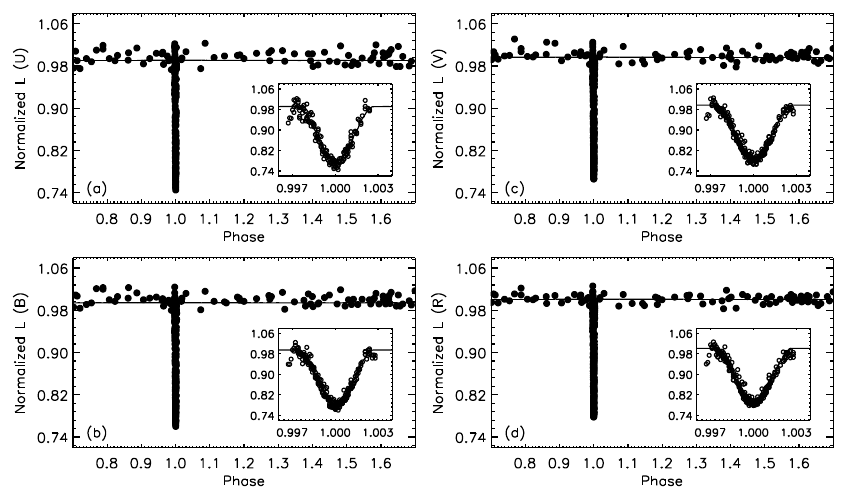
Fig. 2. The UBVR light curves with their theoretical fits. The inserts show the zoomed light curves at the phases of the primary minimum. In the light curve analysis, the radii are quoted as fractions of stellar